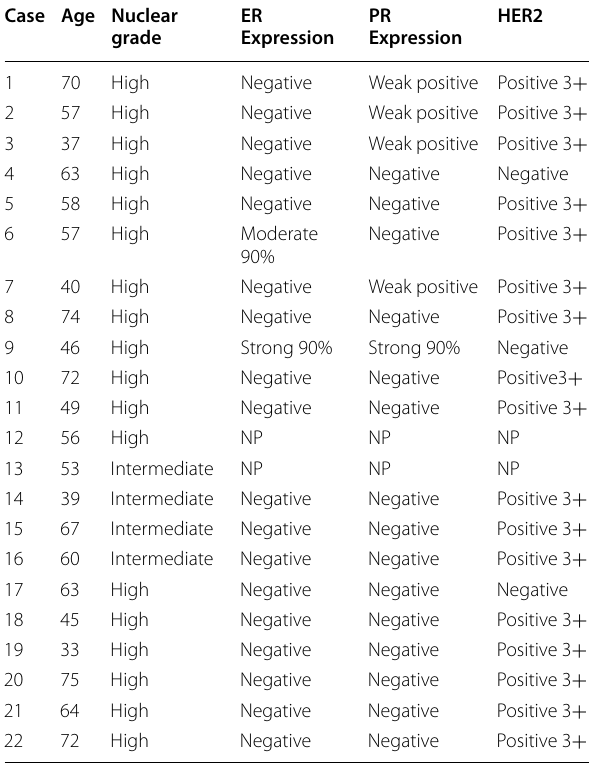
Legend: ER estrogen receptor; PR progesterone receptor; HER2 Human epidermal growth factor receptor, NP not performed